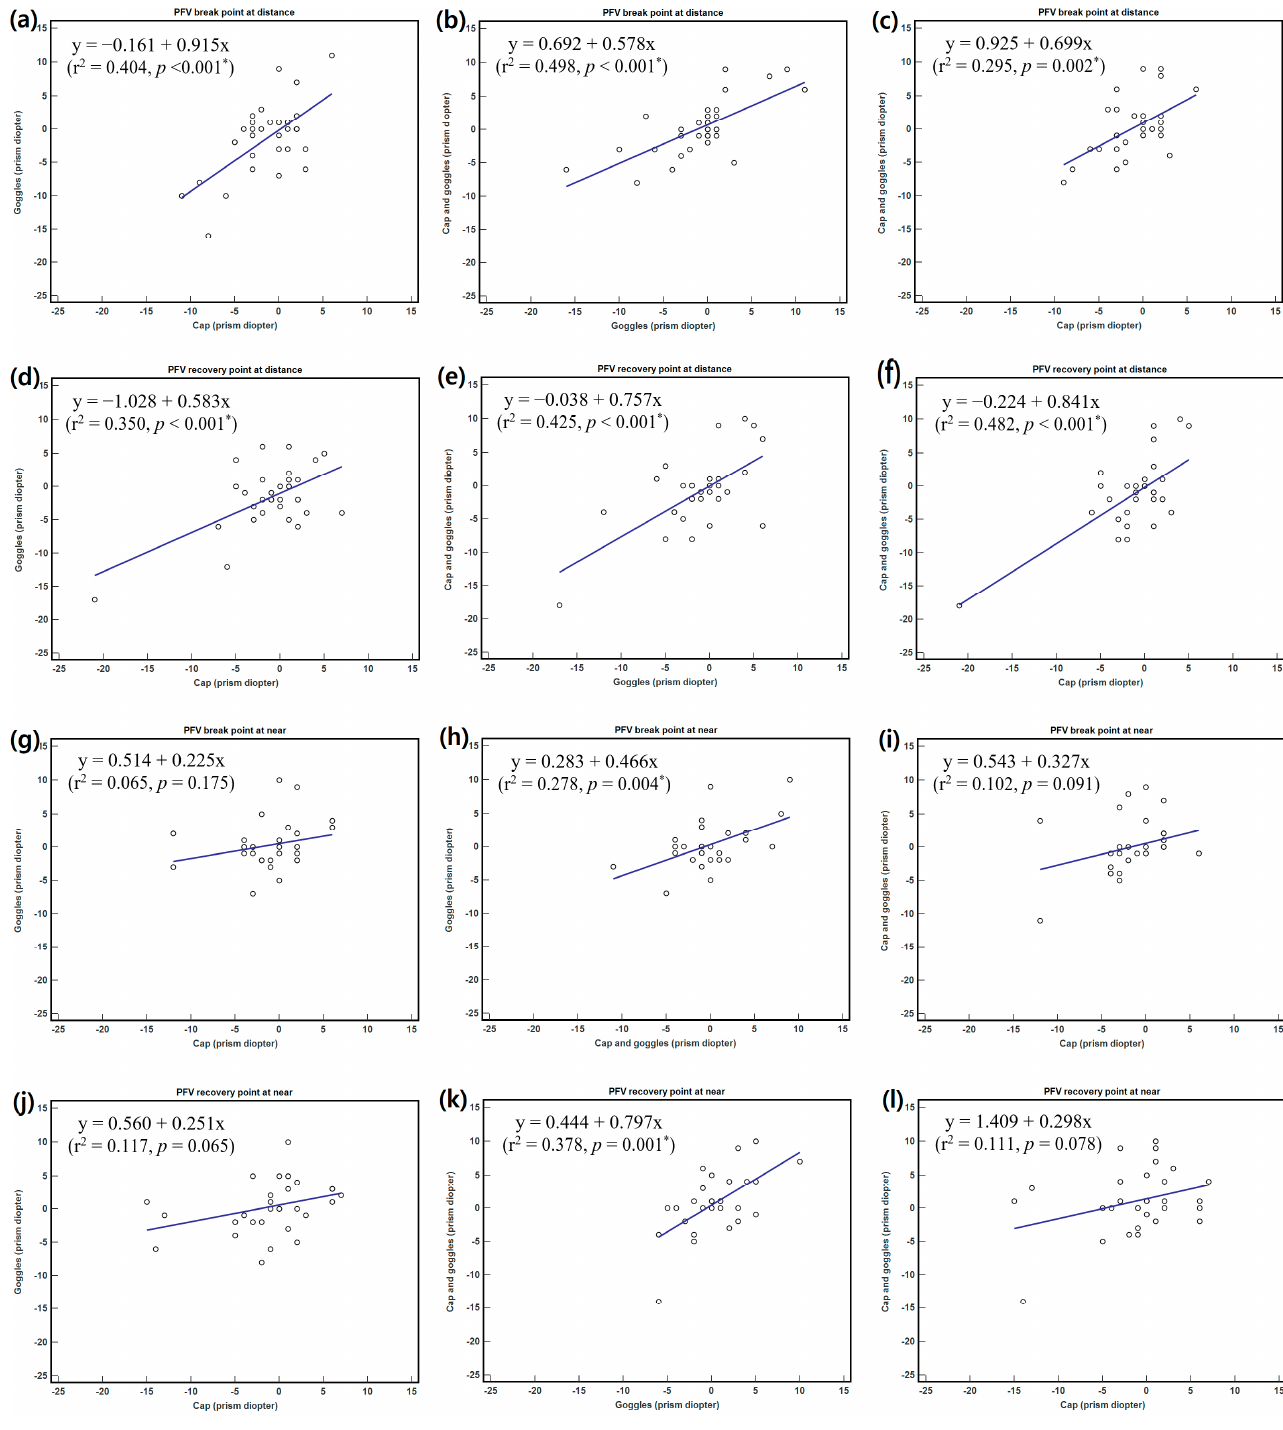
Figure 3. Regression analyses between a swimming cap, goggles, and both a cap and goggles for changes in in break and recovery point of positive fusional vergence (PFV) at distance and near. ( a ) cap vs. goggles, ( b ) goggles vs. cap and goggles, and ( c ) cap vs. cap and goggles for the PFV break point at distance; ( d ) cap vs. goggles, ( e ) goggles vs. cap and goggles, and ( f ) cap vs. cap and goggles for the PFV recovery point at distance; ( g ) cap vs. goggles, ( h ) goggles vs. cap and goggles, and ( i ) cap vs. cap and goggles for the PFV break point at near; ( j ) cap vs. goggles, ( k ) goggles vs. cap and goggles, and ( l ) cap vs. cap and goggles for the PFV recovery point at near. R-squared (r 2 ) is the coefficient of determination. * p < 0.05 indicates a statistically significant finding.